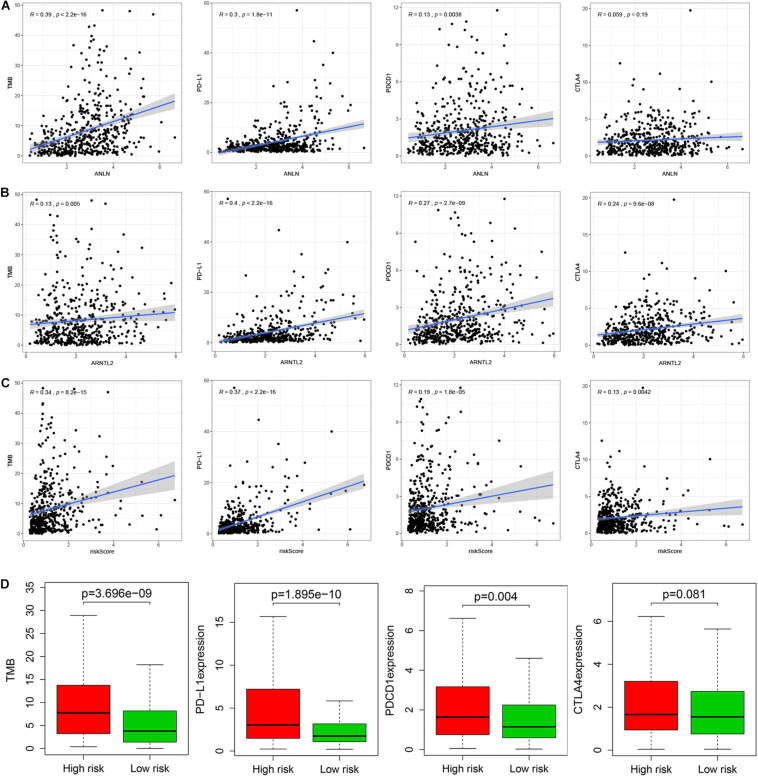
Relationship between ANLN and immune checkpoints (PD-L1, PD-1, and CTLA-4) and TMB (A). Relationship between ARNTL2 and immune checkpoints (PD-L1, PD-1, and CTLA-4) and TMB (B). Relationship between risk score and immune checkpoints (PD-L1, PD-1, and CTLA-4) and TMB (C). Differences in immune checkpoints (PD-L1, PD-1, and CTLA-4) and TMB between high- and low-risk patients (D).